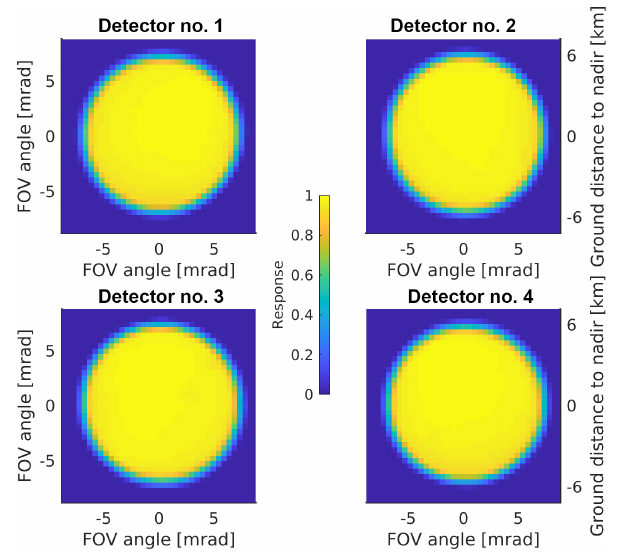
Figure A1. IASI spatial response functions (also known as point spread functions) defined at the viewing angular space. The corresponding ground distance at nadir is shown in the axis on the right. The IASI orbit height is assumed to be 817km above the ground.